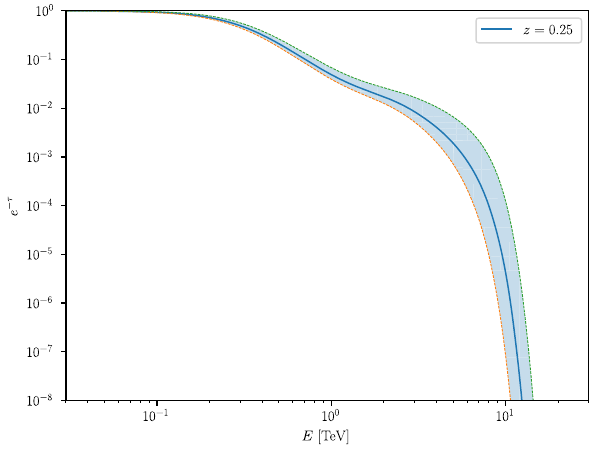
Fig. 5 The EBL attenuation ( e − τ ) of photons from a source with red- shift z = 0 . 25. The model and data are taken from Ref. [50] and http:// side.iaa.es/EBL/